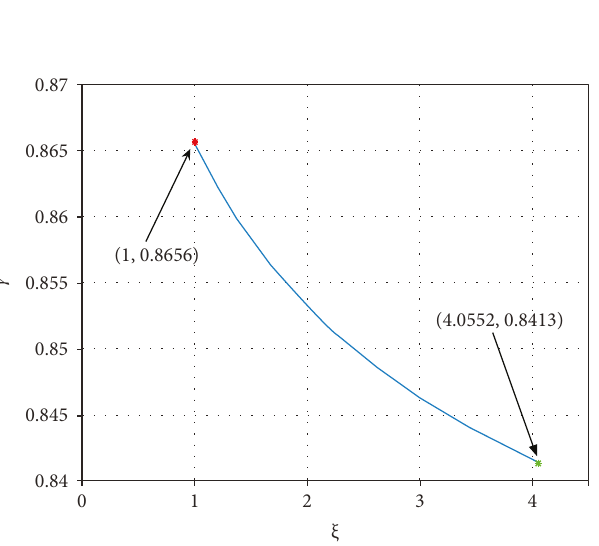
Figure 7: γ versus ξ .